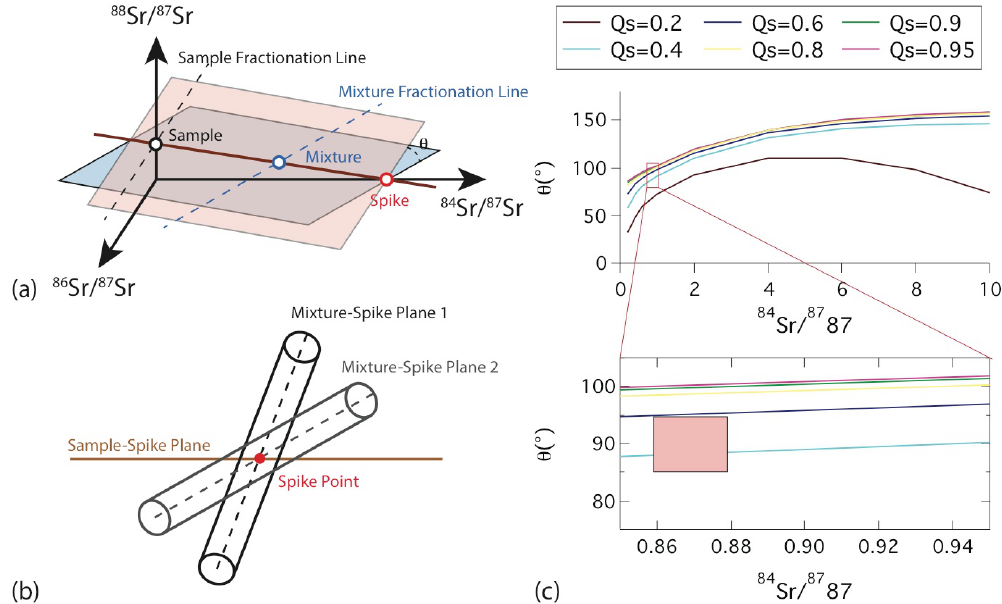
Figure 2. The illustrations of (a) the 84–87 Sr double-spike method, (b) how the angle between mixture-spike plane and sample-spike plane can influence the precision of the deconvolved result, and (c) the optimal sample-spike ratio in our